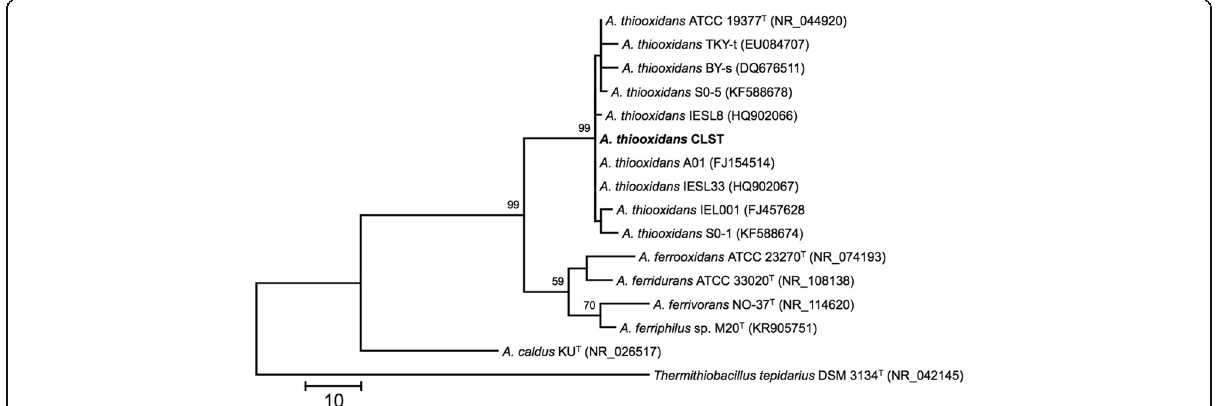
Fig. 1 Phylogenetic tree based on the 16S rRNA gene sequences highlighting the position of Acidithiobacillus thiooxidans strain CLST relative to other type and non-type strains of the genus Acidithiobacillus . The GenBank database accession codes are indicated between brackets. The evolutionary history was inferred by using the Maximum Parsimony and the Subtree-Pruning-Regrafting (SPR) algorithm with search level 1 [52]. The initial trees were obtained by the random addition of sequences. The analysis involved 16 nucleotide sequences and a total of 1307 non-ambiguous positions in the final dataset. Evolutionary analyses were conducted in MEGA version 6.22 [53]. Tree construction used a bootstrapping process repeated 1000 times to generate a majority consensus tree. A sequence from Thermithiobacillus tepidarius was used as outgroup. The tree is drawn to scale, with branch lengths calculated using the average pathway method [53]; the scale bar corresponds to the number of changes over the whole